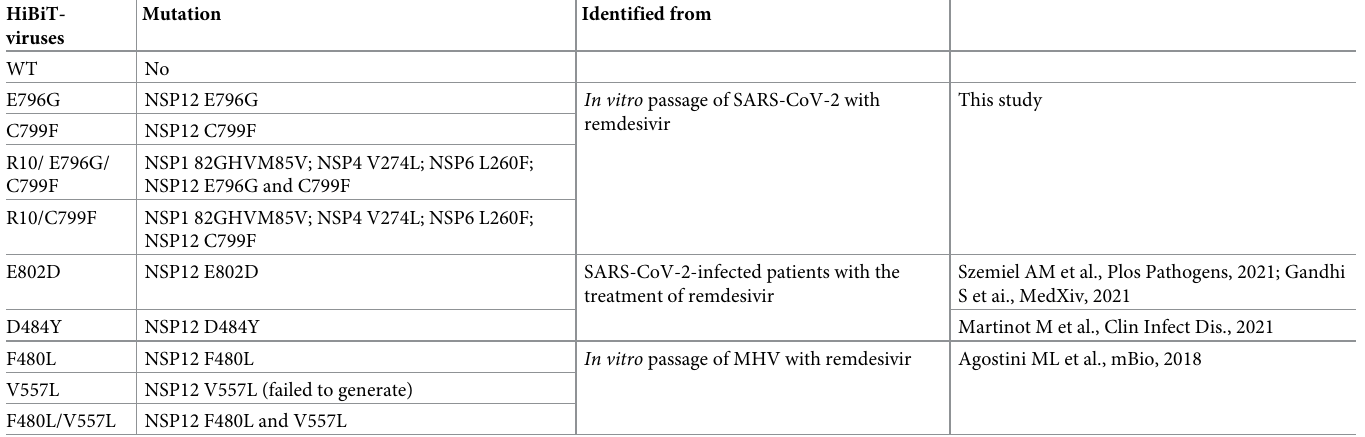
Table 1. Generation of the recombinant SARS-CoV-2 carrying HiBiT reporter and